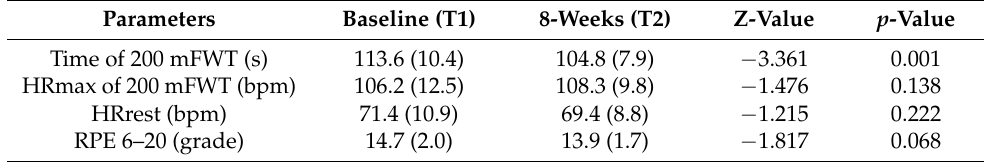
Table 2. Effect of home-based cardiac telerehabilitation intervention on the 200 mFWT. Parameters Baseline (T1) 8-Weeks (T2) Z-Value p -Value Time of 200 mFWT (s) 113.6 (10.4) 104.8 (7.9) − 3.361 0.001 HRmax of 200 mFWT (bpm) 106.2 (12.5) 108.3 (9.8) − 1.476 0.138 HRrest (bpm) 71.4 (10.9) 69.4 (8.8) − 1.215